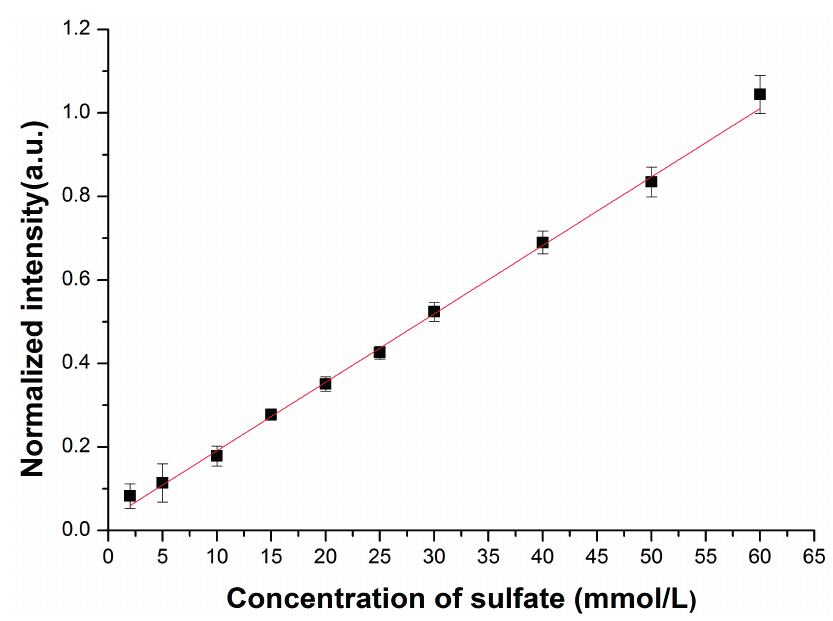
Figure 5. The calibration curve of sulfate concentration with LCOF-Raman spectroscopy.